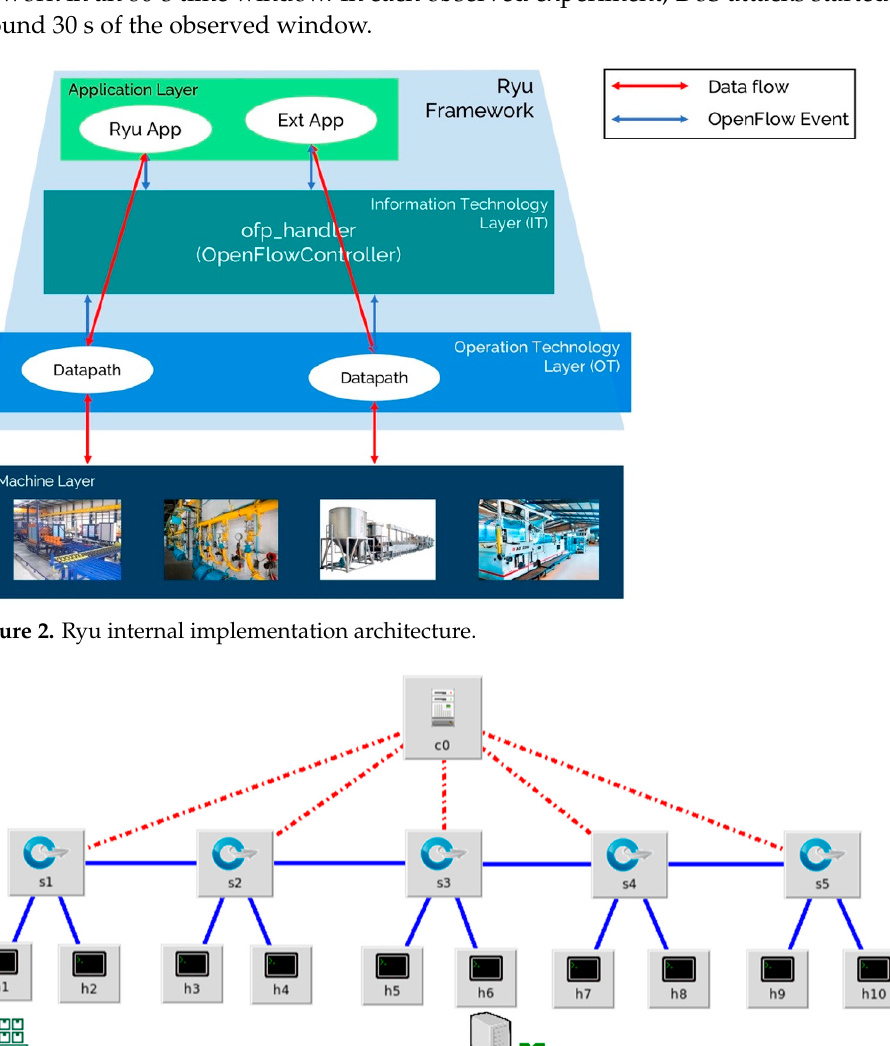
Figure 2. Ryu internal implementation architecture.